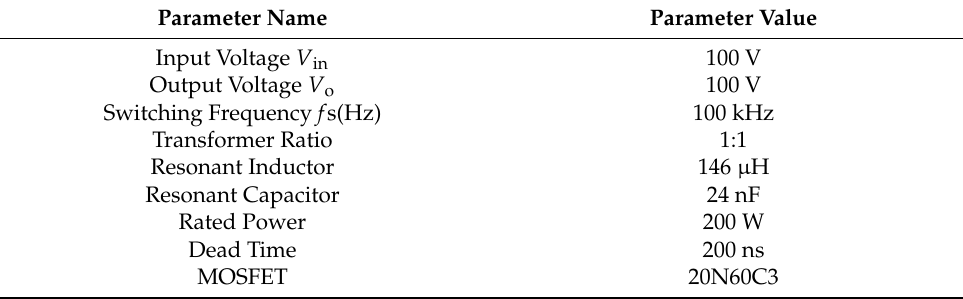
Table 5. Main circuit parameters of the experimental prototype.